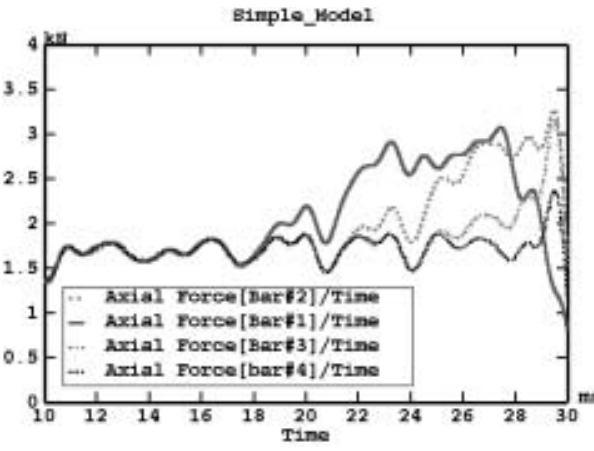
Fig. 8. Simulated axial forces of connecting bars in simple